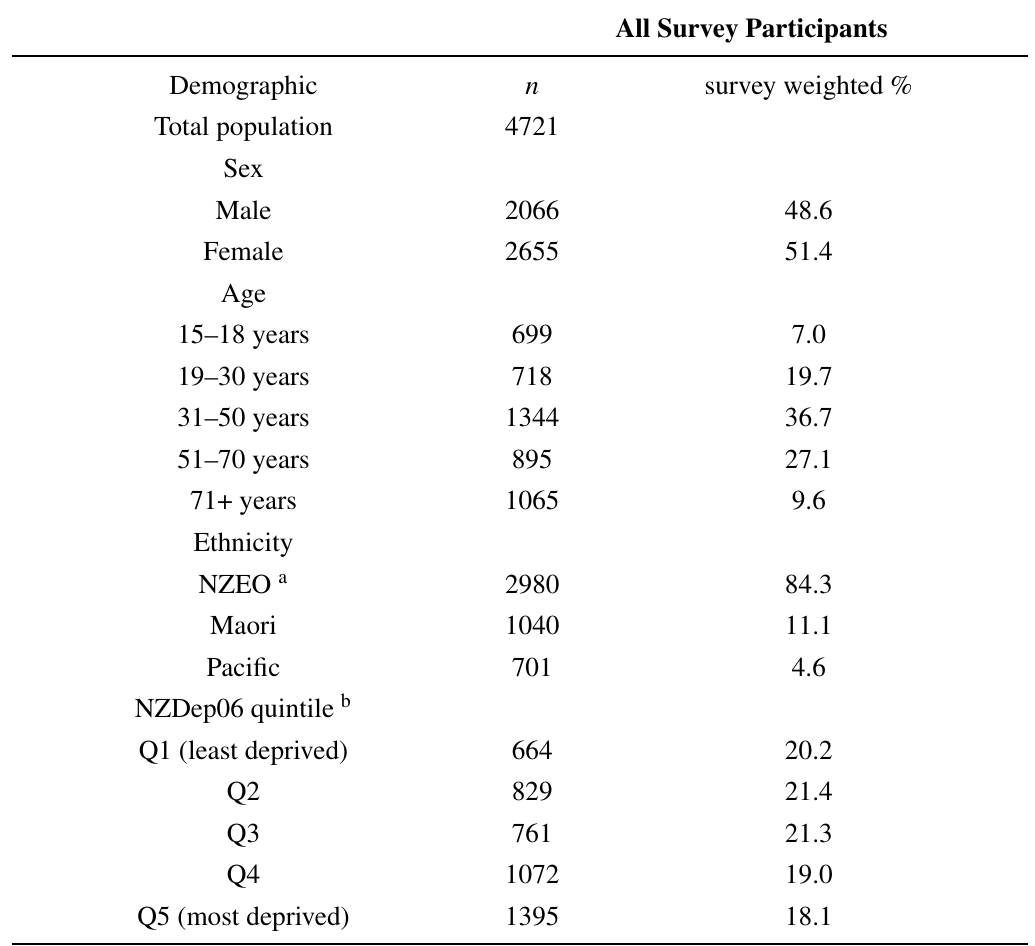
Table 1. Characteristics of survey